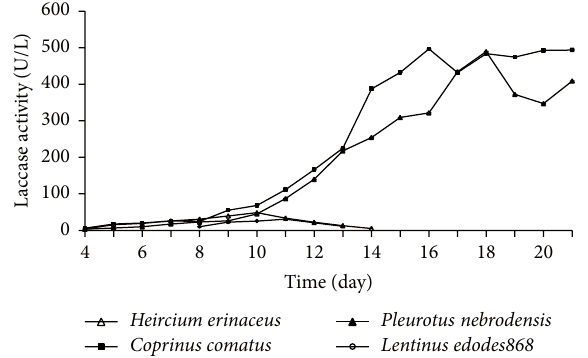
Figure3:Timecoursesoflaccaseactivityof4strains.Fivemycelium agar discs (5mm diameter) were used as the inoculum. Cultivated in potato dextrose liquid medium, 1mL Zymotic fluid of the strains wastakenoutoftheflaskforexperimenteachday.Thedatarepresent the average of three independent